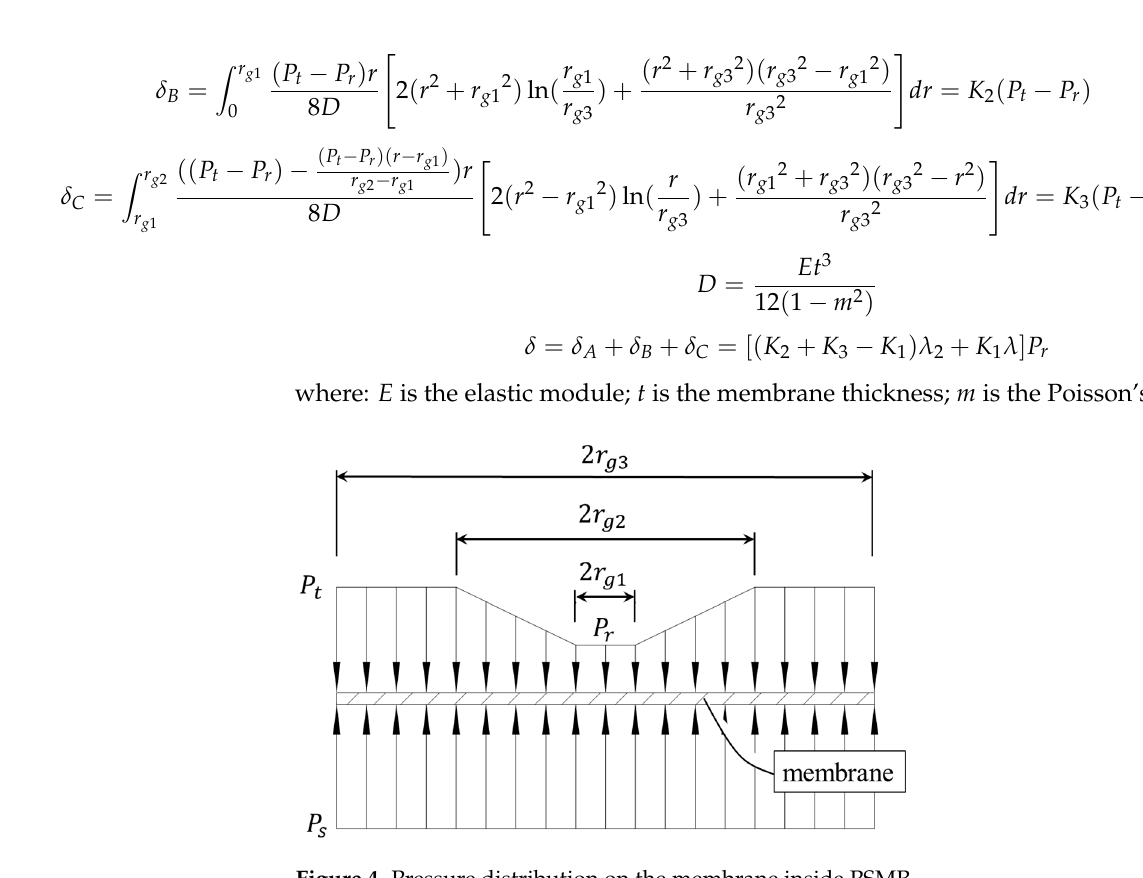
Figure 4. Pressure distribution on the membrane inside PSMR.